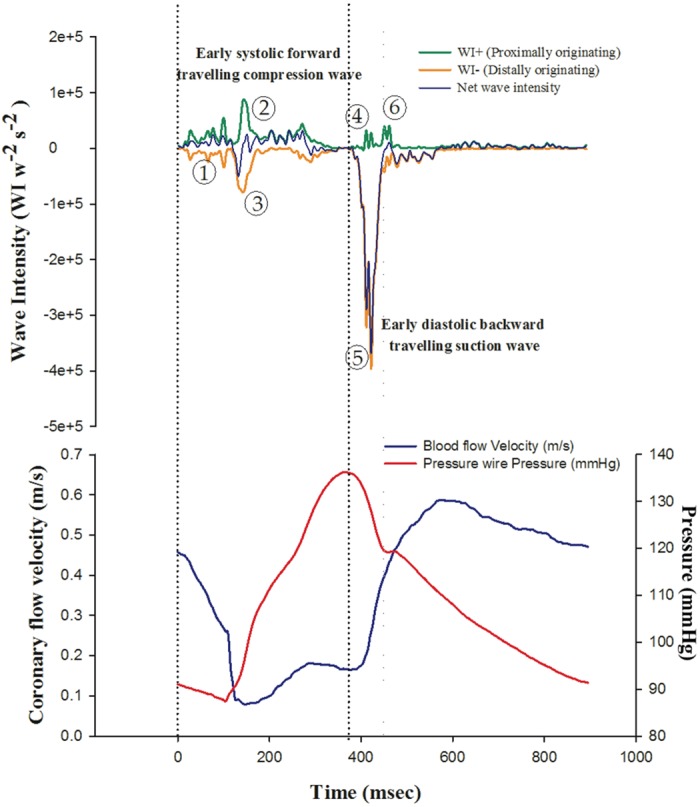
Origins and effects of waves within the coronary circulation.A representative example of coronary pressure and flow velocity with calculated net wave intensity and separated wave intensity profiles measured over a single cardiac cycle is shown. Measurements were taken in the distal vessel, following stenting of the target stenosis during resting conditions. 6 major waves have been identified within the coronary circulation. These waves are hypothesized to explain coronary pressure and flow velocity over a complete cardiac cycle. Waves are numbered according to their sequence of arrival during the cardiac cycle (see Table 1). The early systolic forward travelling compression wave (sFCW) and early diastolic backward travelling decompression wave (dBEW) have been proposed as the primary accelerative forces acting on coronary flow. FFR, Fractional Flow reserve; CFVR, Coronary Flow Velocity Reserve; sFCW, systolic Forward travelling Compression Wave; dBEW, diastolic Backward travelling Expansion Wave.